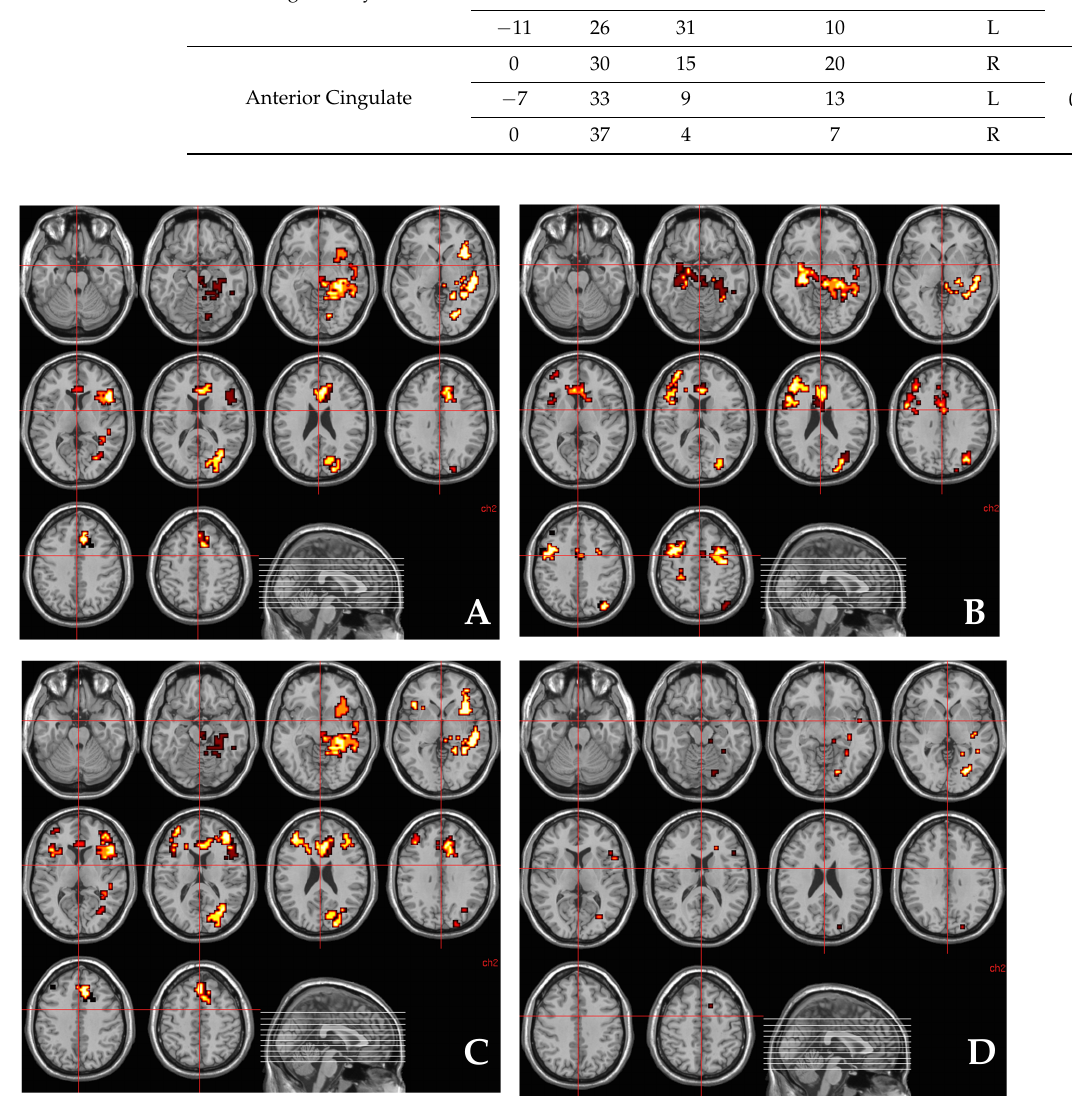
Figure 2. ( A ) Regions of brain activation showing significantly greater correlation with the number of A alleles of the AKT1 rs1130233 polymorphism under THC condition than under placebo condition while viewing fearful faces. The left side of the brain is shown on the left side of the image. ( B ) Regions of brain activation showing significantly greater correlation with methylation percentage at CpG island 11–12 around rs1130233 polymorphism in the AKT1 gene under THC condition than under placebo condition while viewing fearful faces. The left side of the brain is shown on the left side of the image. ( C ) Regions of brain activation showing significantly greater correlation with the number of A alleles of the AKT1 rs1130233 polymorphism under THC condition than under placebo condition while viewing fearful faces after controlling for percentage methylation at CpG island 11–12 around rs1130233 polymorphism in the AKT1 gene. The left side of the brain is shown on the left side of the image. ( D ) Clusters of brain activation where the significantly greater correlation between the number of A alleles of the AKT1 rs1130233 polymorphism under THC condition than under placebo condition while viewing fearful faces may be mediated by correlation with methylation percentage at CpG island 11–12 around rs1130233 polymorphism in the AKT1 gene. The left side of the brain is shown on the left side of the image.